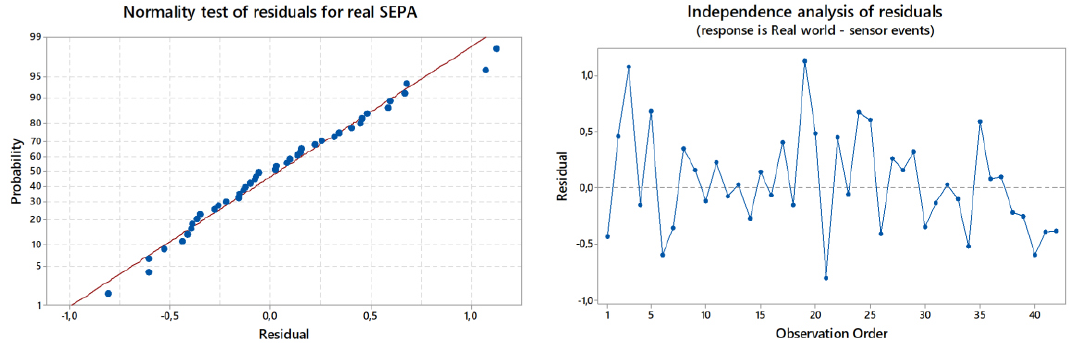
Figure 6. QQ-plot and auto-correlation of real SEPA: Poisson regression model with dummy